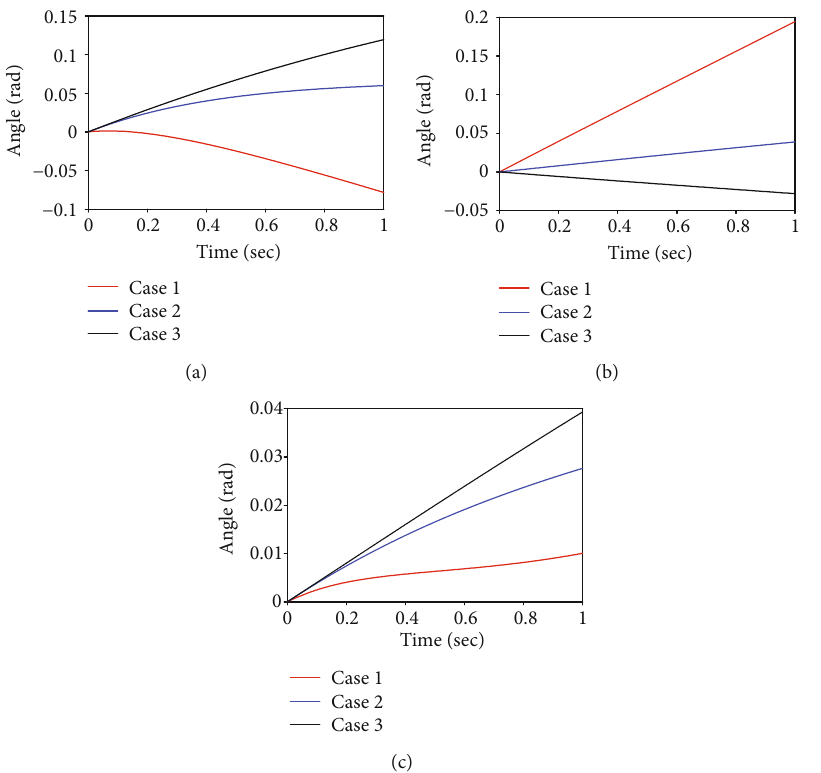
Figure 18: Attitude of the target satellite during identi fi cation: (a) X axis, (b) Y axis, and (c) Z axis.